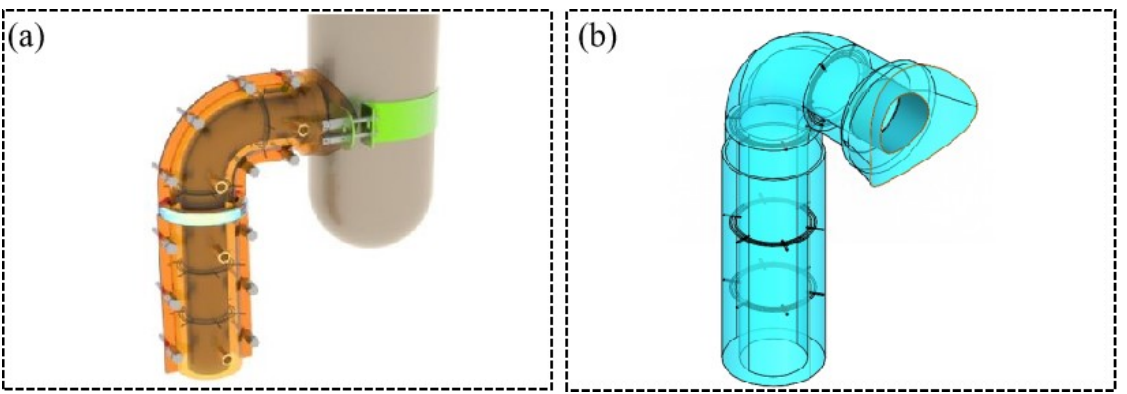
Figure 3. A numerical model of the exterior clamp and the plugging substance: ( a ) models of the exterior clamp; ( b ) models of the plugging agent substance.